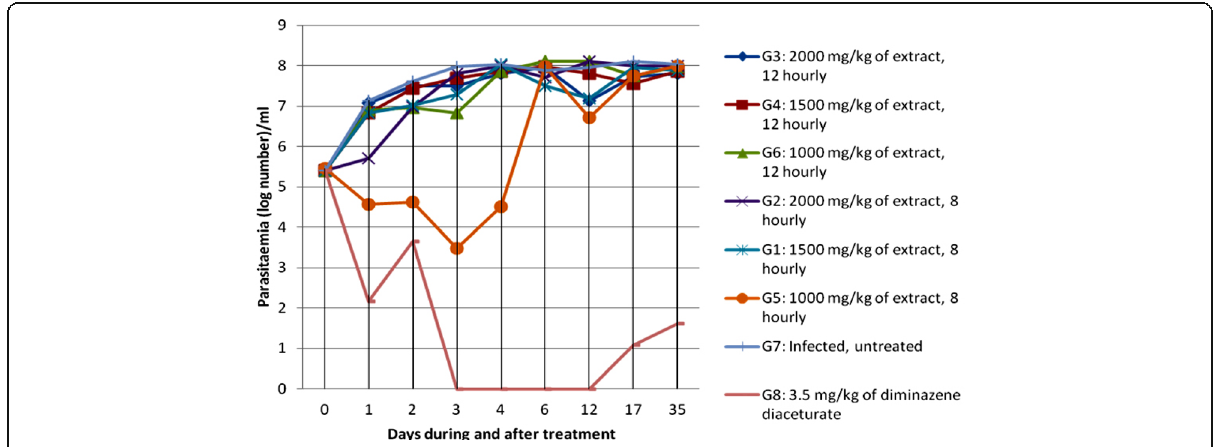
Fig. 2 Trend of the mean parasitaemia of T. congolense during and after treatment of extract of C. swynnertonii